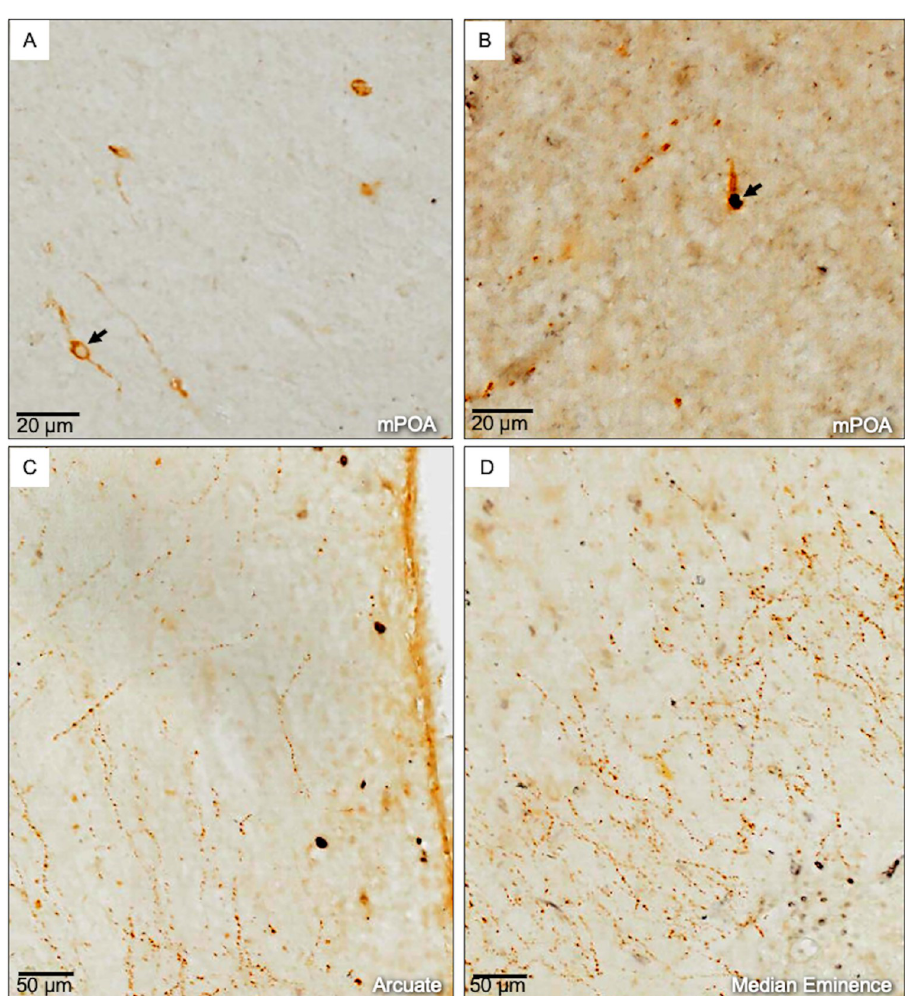
Fig 3. Distribution of GnRH and c-FOS immunoreactive cells in the preoptic area and hypothalamus after administration of 3 doses of 15 mg human Kisspeptin-10 intravenously (at 1 hr intervals) during proestrous phase of estrous cycle in cows. A) GnRH immunoreactive neurons (arrow) in the medial preoptic area (mPOA) nucleus showing cytoplasmic DAB (brown) staining. B) GnRH immunoreactive neurons that co-express c-FOS immunoreactive reaction (Nickel-DAB black color). Note that c-FOS is localized in the nucleus (arrow). C-D) GnRH (brown) and c-FOS (black) immunoreaction cells and nerve fibers in the arcuate nucleus and median